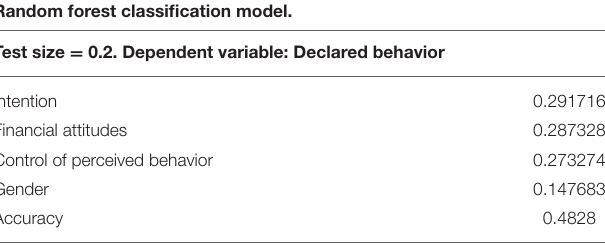
TABLE 6 | Ordered logistic regression for the variable potential behavior . Ordered logistic regression. Dependent variable: declared behavior